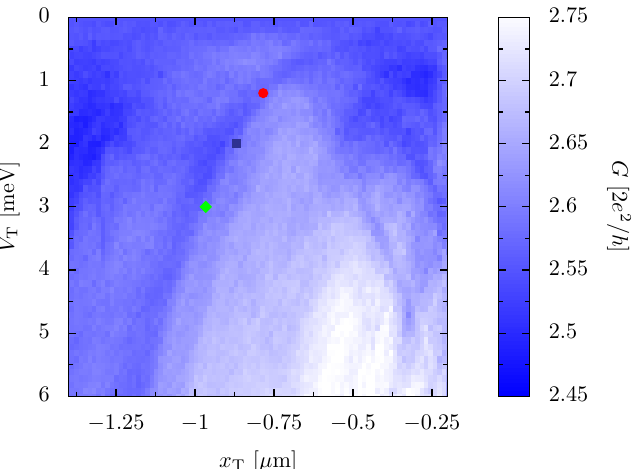
Figure 5: Zoom in the lower left part of Fig. 4. The three marked points on the prominent edge between high and low conductance represent the parameter values for which the classical trajectory density is shown in Fig. 6.